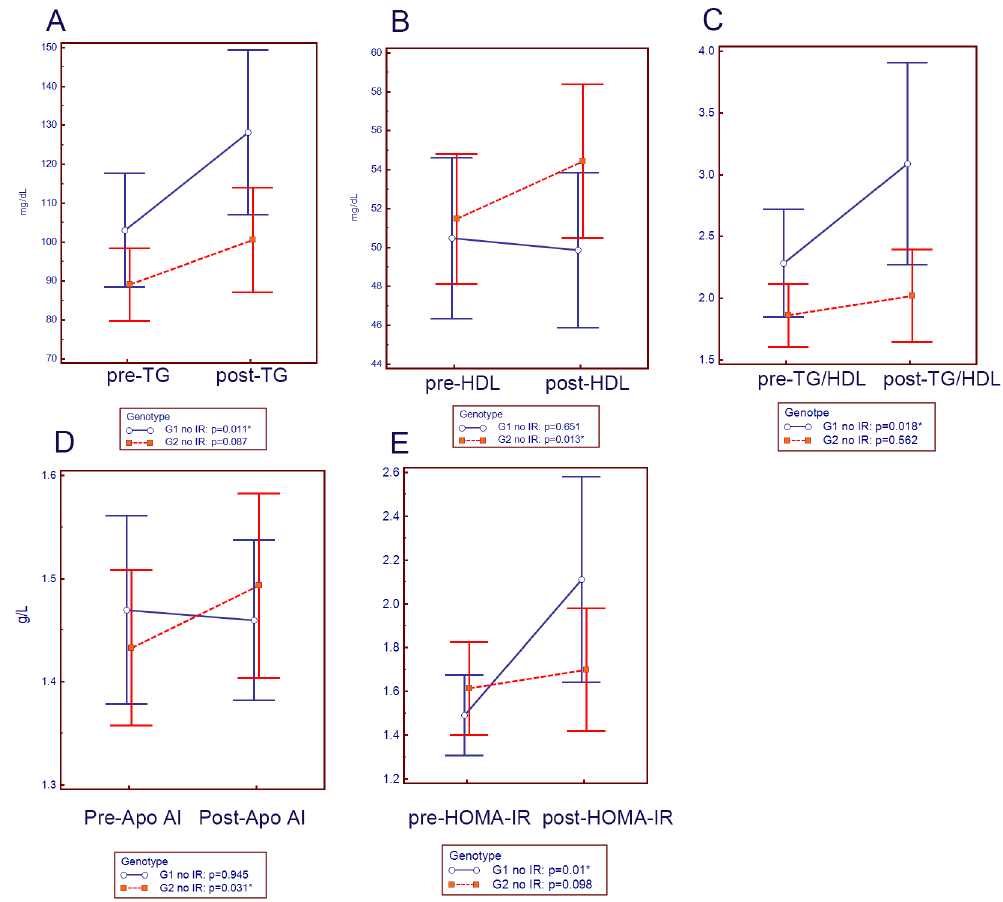
Figure 1. Comparisons of the pre- and post-treatment variables when using paired-t tests. Pre-: pre-treatment; post-: post-treatment; G1 no IR: G1 CHC patients without baseline IR achieved SVR (n=65); G2 no IR: G2 CHC patients without baseline IR achieved SVR (n=67). *: p , 0.05.